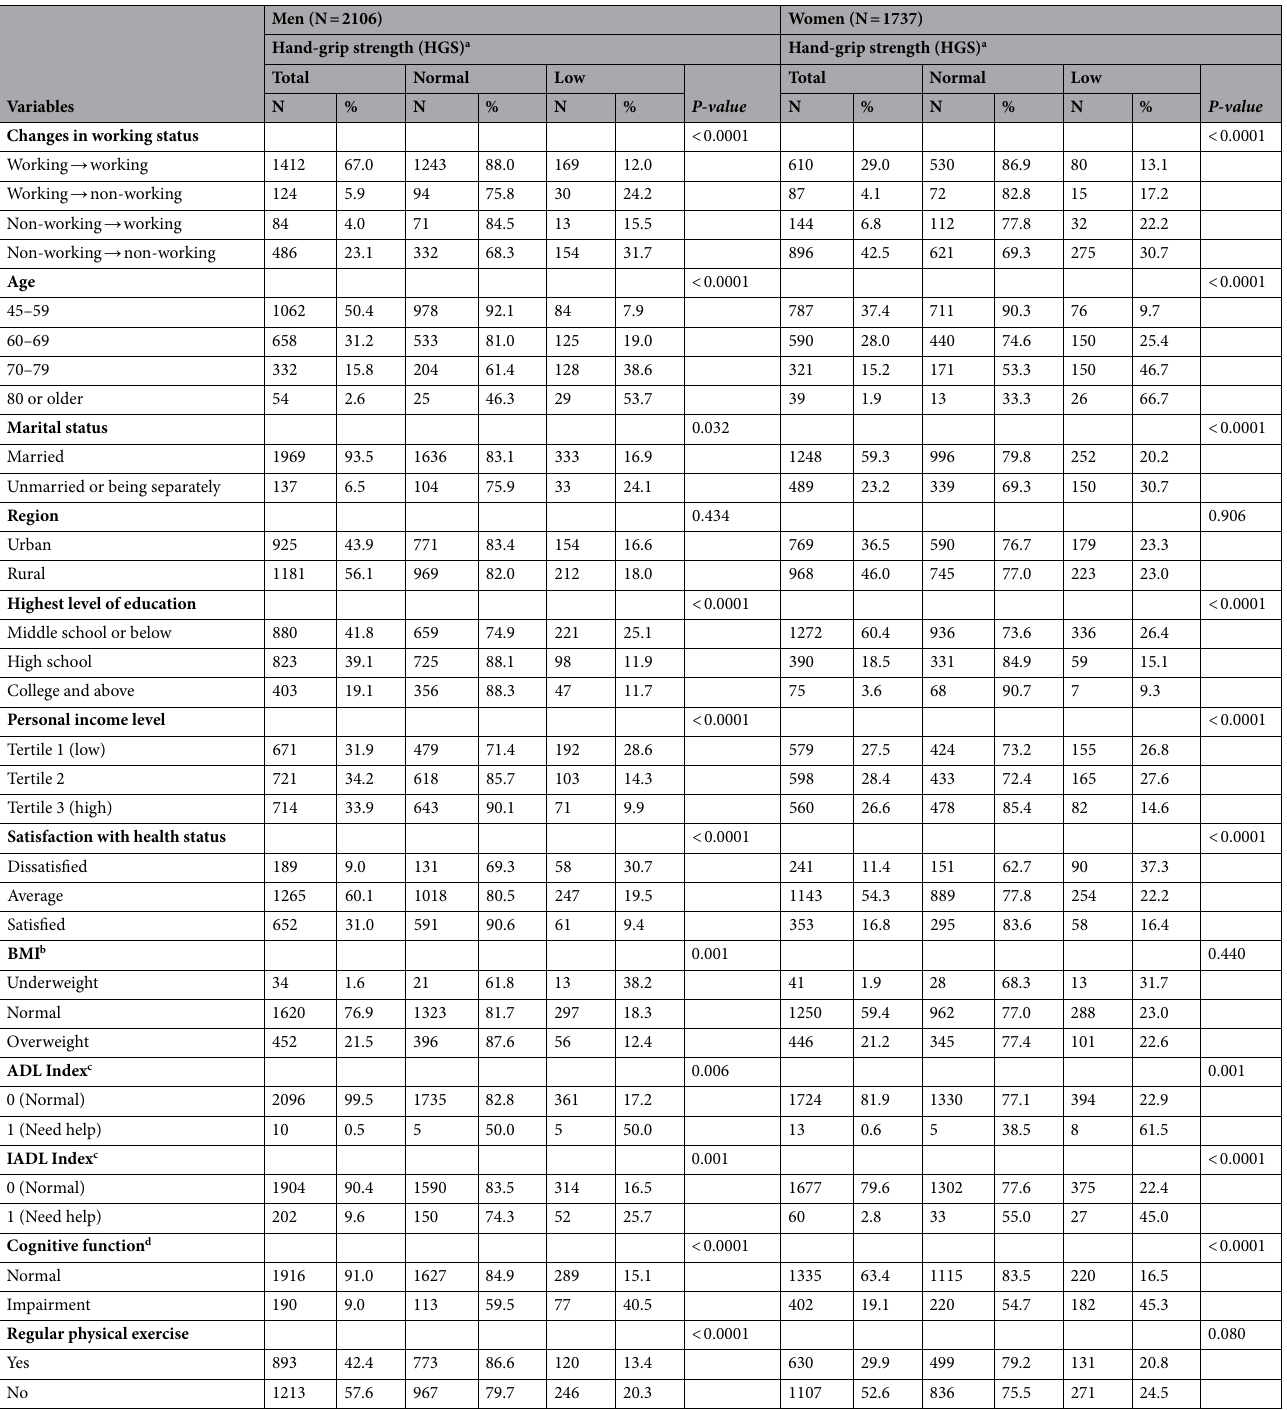
Table 1. General characteristics of the study population (2006 → 2008 baseline year). BMI, Body Mass Index; ADL, Activities of Daily Living; IADL,Instrumental Activities of Daily Living. a As defined by AWGS (Asian Working Group for Sarcopenia), cut-off points of hand-grip strength were 28 kg for men and 18 kg for women. b Underweight (BMI of less than 18.5 kg/m 2 ), Normal (BMI of 18.5–24.9 kg/m 2 ), Overweight (BMI of 25 kg/ m 2 or over). c 0 point (If they do not need any help), 1 point (If they need some help, or if they need help altogether). d Normal (MMSE score of 24 points or more), Impairment (MMSE score of 23 points or